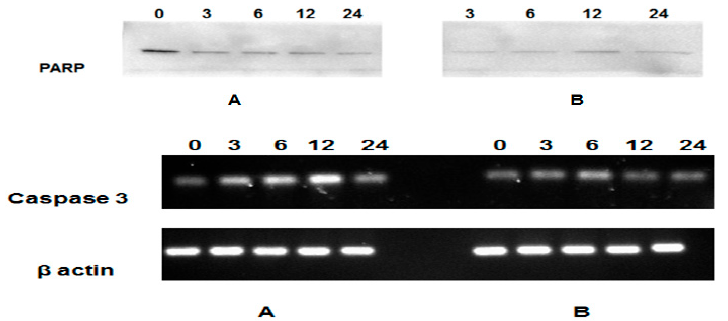
Figure 7. Treatment of HT29 cells with DEN and/or DEN-HP β CD complex showed in activation of caspase-3, 9 and 8. Cells were treated with 3, 6, 12 and 24 µg/mL for 24 h, and then determination of caspase-3, 9 and 8 activity was done. Mean ± standard deviation (SD). ( n = 3 well/treatment). * p < 0.05 compared with untreated cells. RT-PCR analysis for caspase-3 mRNA expression was stimulated in treated and untreated cells. β -actin used as control. Part A represents caspase-3 and β actin mRNA expression in DEN-HT29 treated cells, Part B represents caspase-3 and β actin mRNA expression in DEN-HP β CD-HT29 treated cells. The effect of DEN and DEN-HP β CD complex on apoptosis regulatory proteins in the treated HT29 colon cancer cell line was determined by Western blot assay.